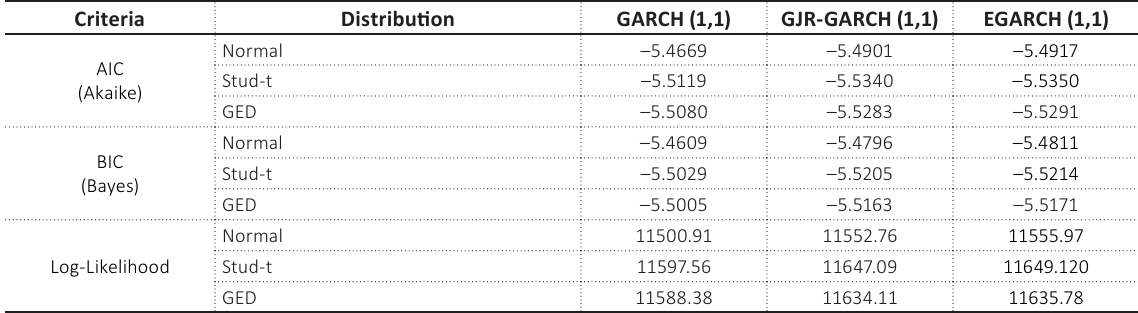
Table 5. Model selection criteria